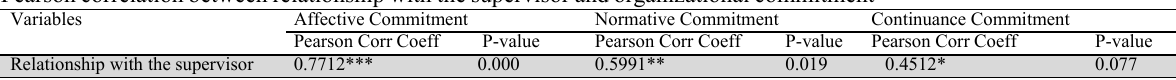
Pearson correlation between relationship with the supervisor and organizational commitment Variables Affective Commitment Normative Commitment